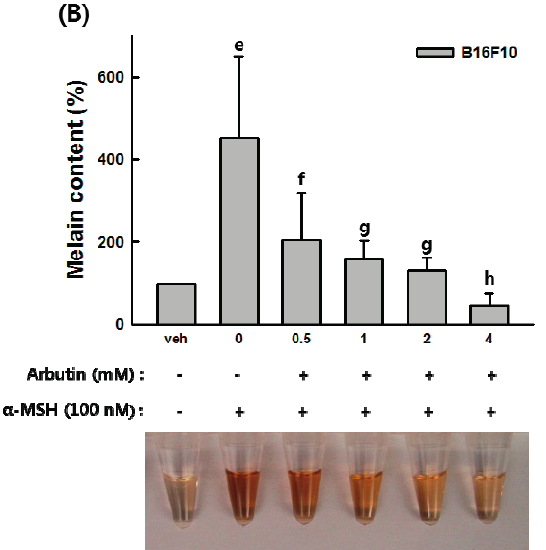
Figure 5. Anti-melanin formation effect of PCP against α -MSH stimulation in